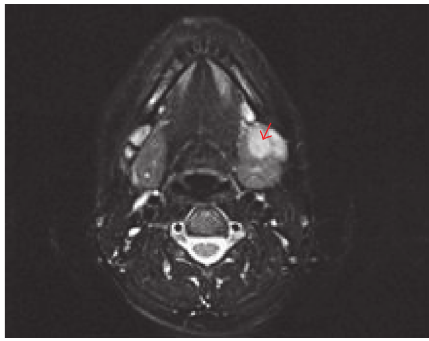
Figure 2: Axial T2 MRI of the head and neck at initial presentation illustrating the left submandibular gland mass